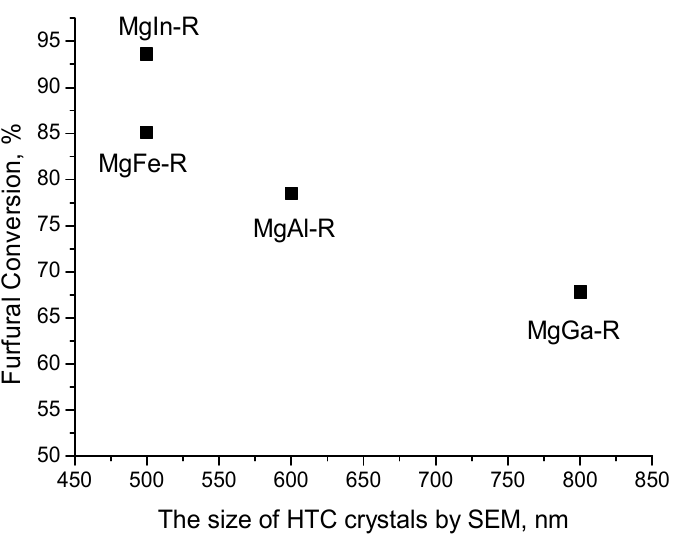
Figure 5. A correlation between the size of HTC platelets in rehydrated MgM-R20 hydrotalcites evaluated by SEM and furfural conversion over these catalysts after 180 min of the reaction.